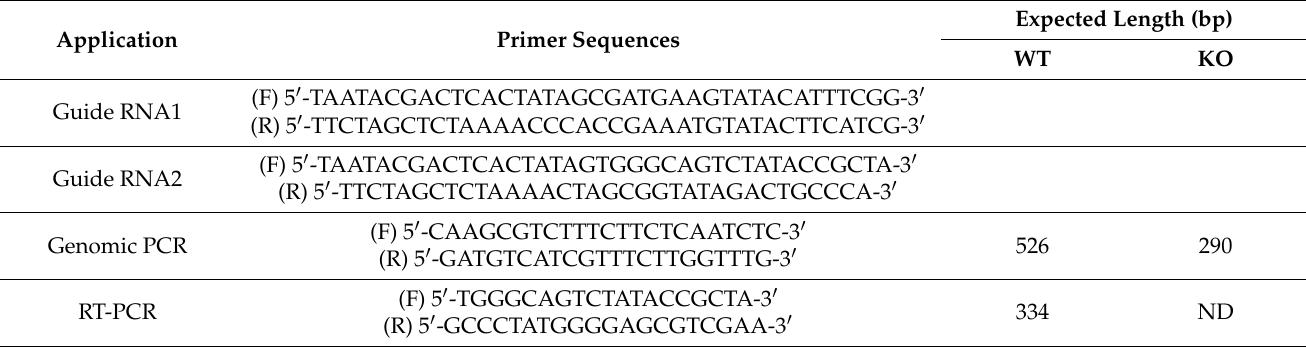
Expected Length (bp) WT KO